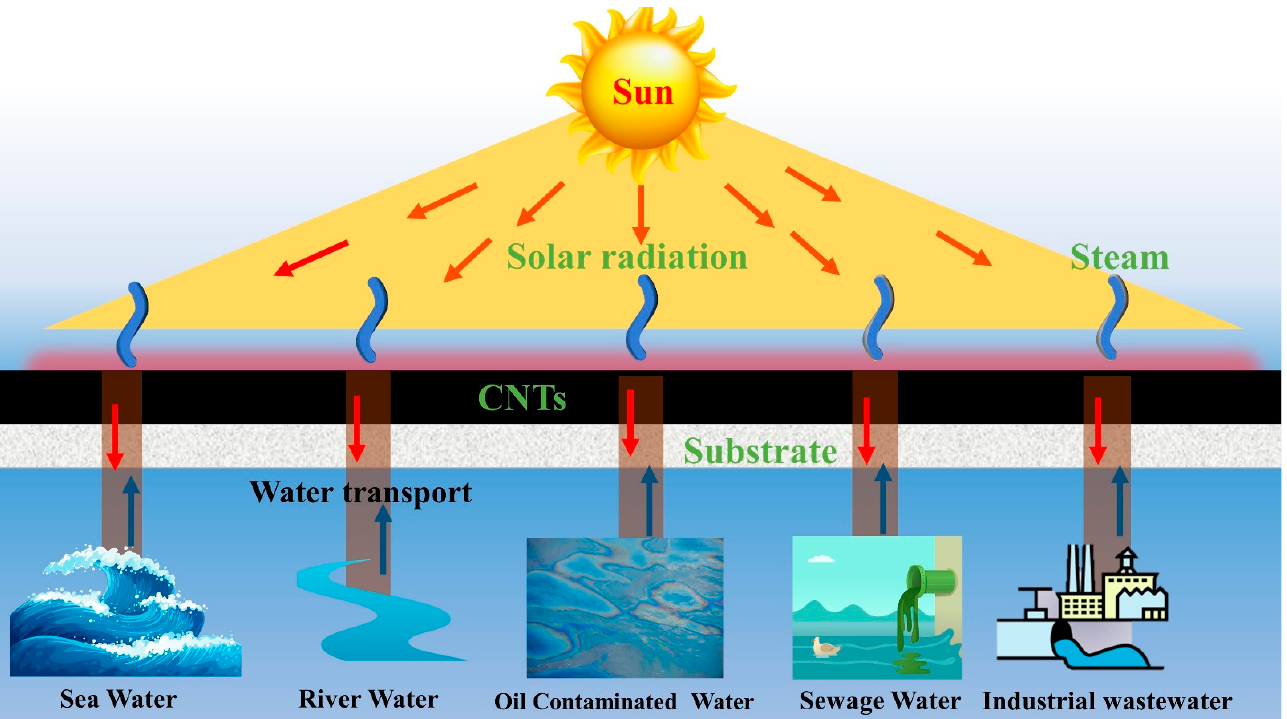
Figure 2. Schematic illustration of CNTs’ photothermal-conversion-based solar water purification process. Solar water purification methods have focused on increasing evaporation